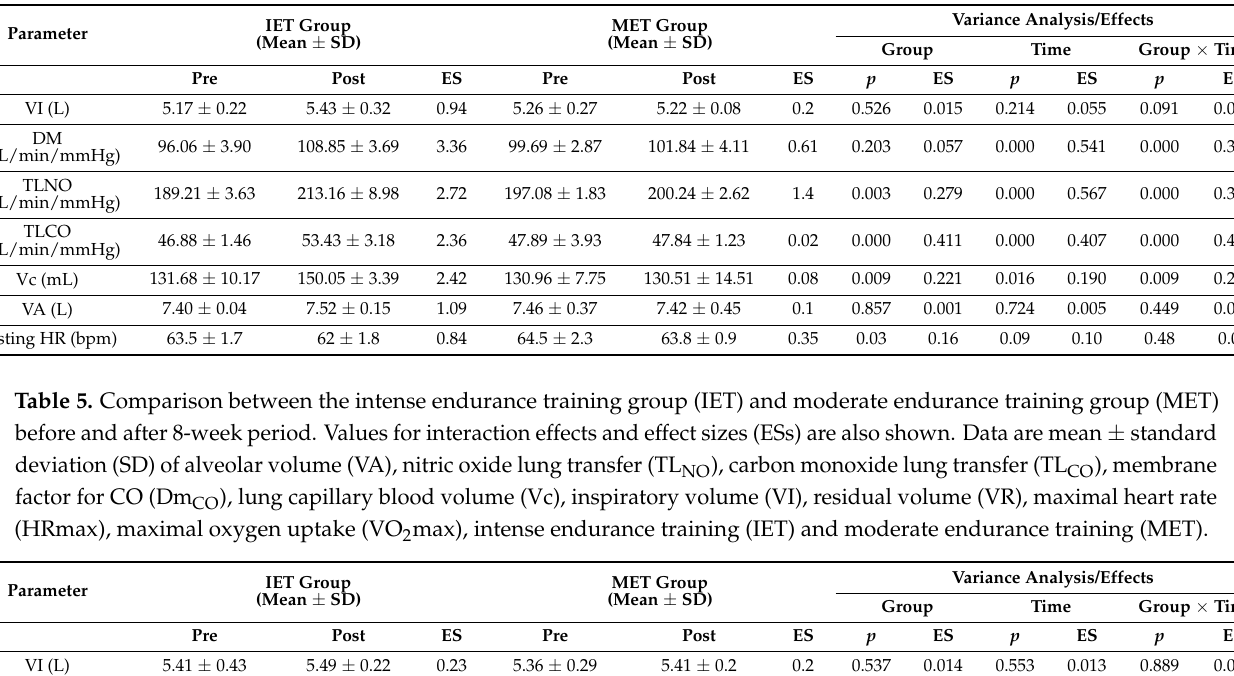
Table 4. Pulmonary parameters measured at rest: alveolar volume (VA), nitric oxide lung transfer (TL NO ), carbon monoxide lung transfer (TL CO ), membrane factor for CO (Dm CO ), lung capillary blood volume (Vc), inspiratory volume (VI), residual volume (VR) and resting heart rate (HRr) before and after training program in experimental and control groups. Values for interaction effects and effect sizes (ESs) are also shown. Data are mean ± standard deviation (SD) of alveolar volume (VA), nitric oxide lung transfer (TL NO ), carbon monoxide lung transfer (TL CO ), membrane factor for CO (Dm CO ), lung capillary blood volume (Vc), inspiratory volume (VI), residual volume (VR) and resting heart rate (Resting HR), intense endurance training (IET) and moderate endurance training (MET).